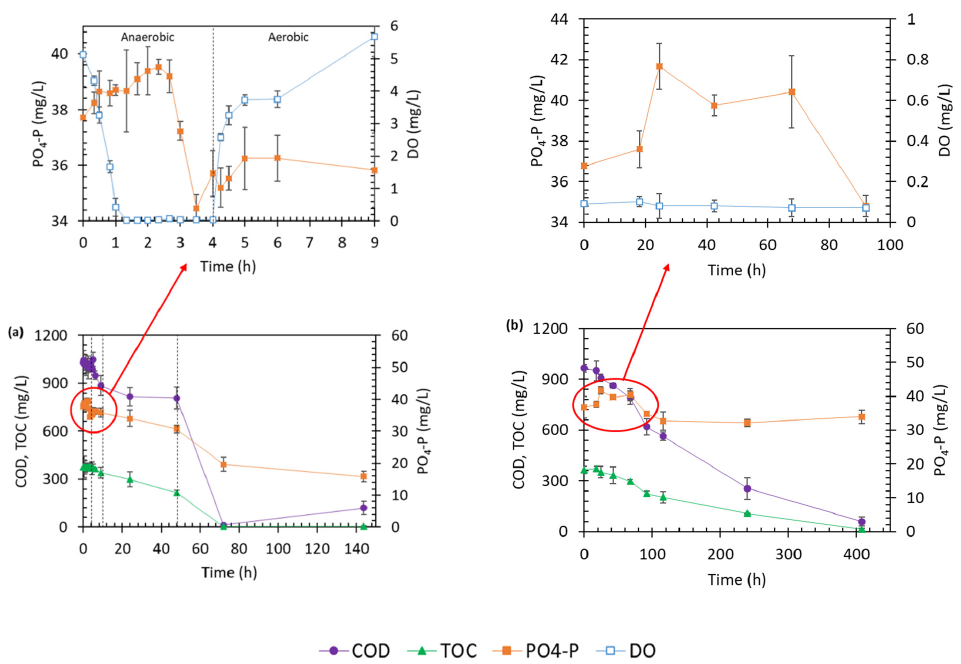
Figure 2. Treatment performance of ( a ) alternating anaerobic/aerobic (AN/O_AS) and ( b ) extended anaerobic activated sludge (ExAN_AS) bioreactors.